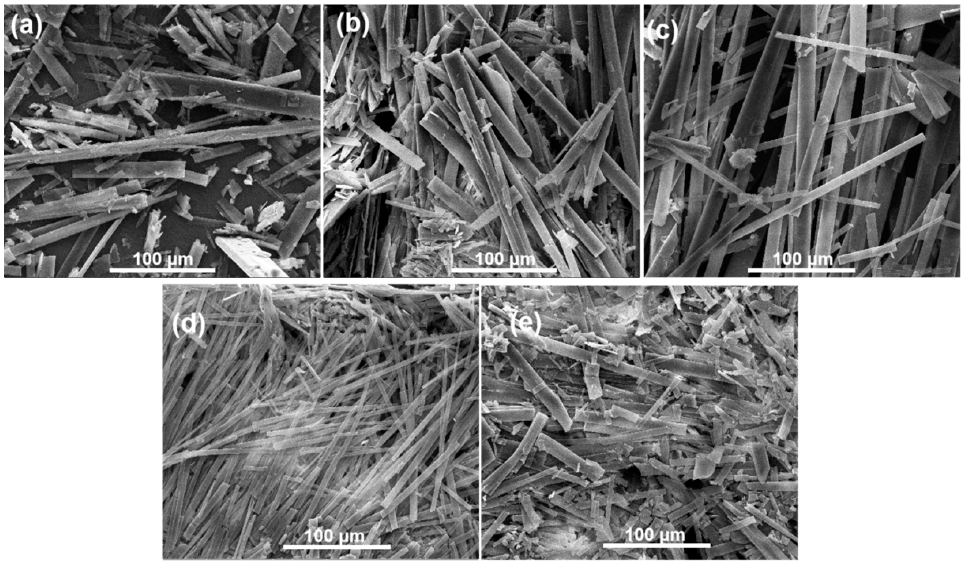
Figure 2. SEM images of GA-O-09 gel with different equivalents of copper ions: ( a ) 0 equivalent; ( b ) 0.2 equivalent; ( c ) 0.5 equivalent; ( d ) 0.8 equivalent; ( e ) 1.0 equivalent.